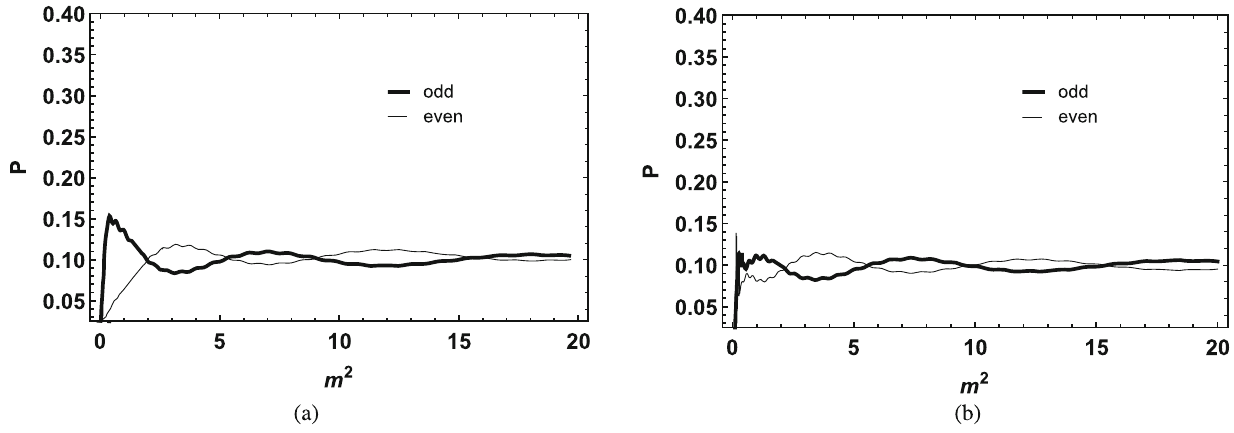
Fig. 9 The behavior of the relative probability P ( m ) for G 2 (φ) with n = 2, b = 4 k = − 0 . 1 and p = λ = 1. a Gauge field. b KR